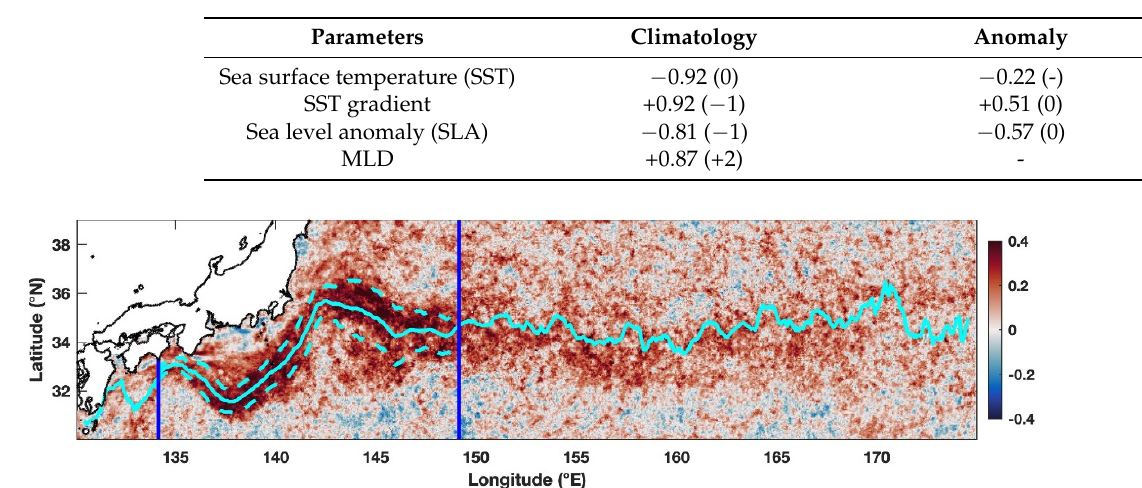
Table 1. The correlation coefficient between the monthly time series of chlorophyll concentrations (Chl-a) and different parameters in climatological and anomalous fields for the enclosed region shown in Figure 6. The anomalous field is obtained using the monthly time series by removing the overall average for the corresponding month. The number in the bracket indicates the number of months for the parameter to obtain the correlation with Chl-a with the largest magnitude, where a positive (negative) value indicates the parameter is leading (lagging) the variability in Chl-a. The dash symbol indicates that the correlation is not significant at the 95% confidence level. Because mixed layer depth (MLD) is obtained as a monthly climatology, the correlation in the anomalous field is not available.